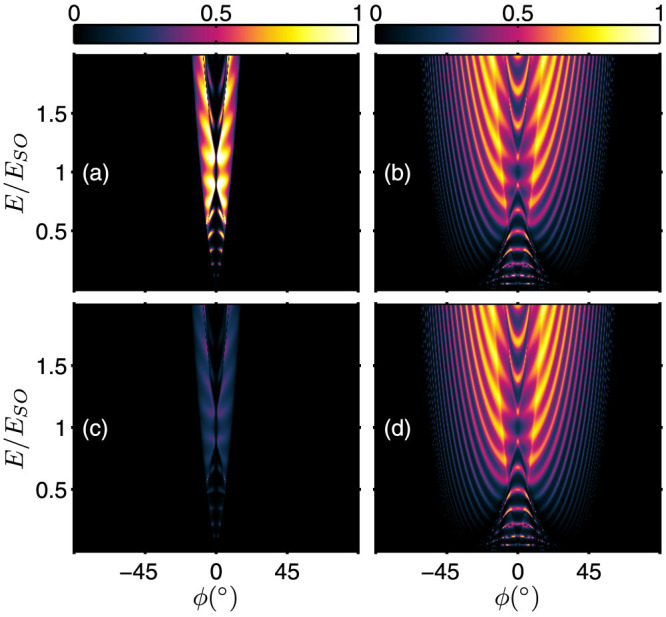
Energy spectrum of the transmission probabilities in the presence of asymmetrical interface scattering potential, ZL ≠ ZR.(a) ; and (b)  for ZL = 0.5 and ZR = 1.5; (c) ; and (d)  for ZL = 1.5 and ZR = 0.5. (The junction tunneling parameters are the same as Figure 4)